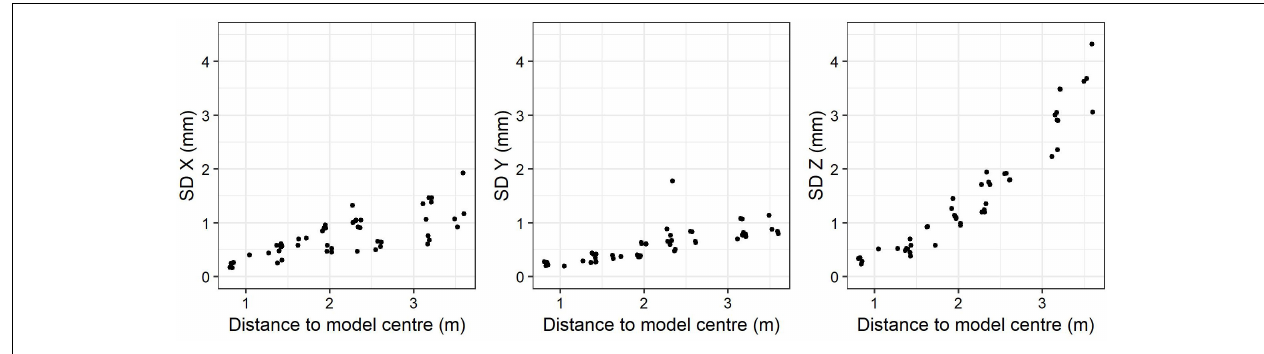
FIGURE 5 | Standard deviation of marker coordinates for the 3 axes, in function of the distance to the model center. SD, standard deviation.